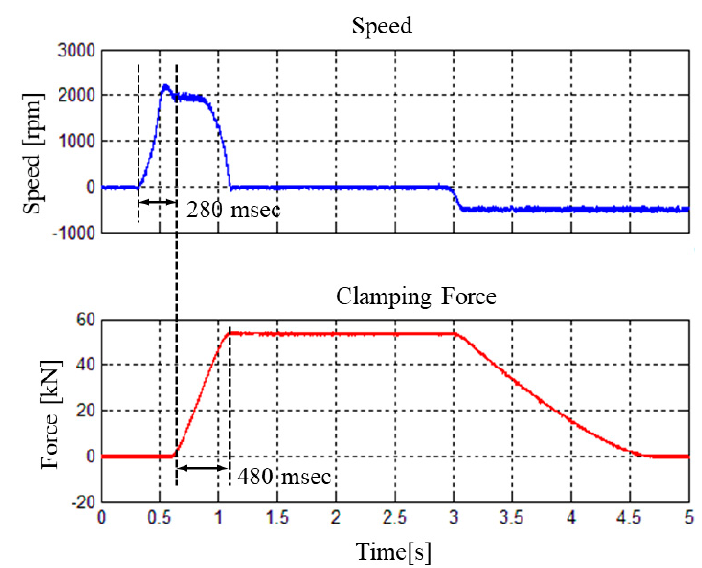
Figure 16. Experimental result of speed control. Energies 2018 , 11 , x FOR PEER REVIEW